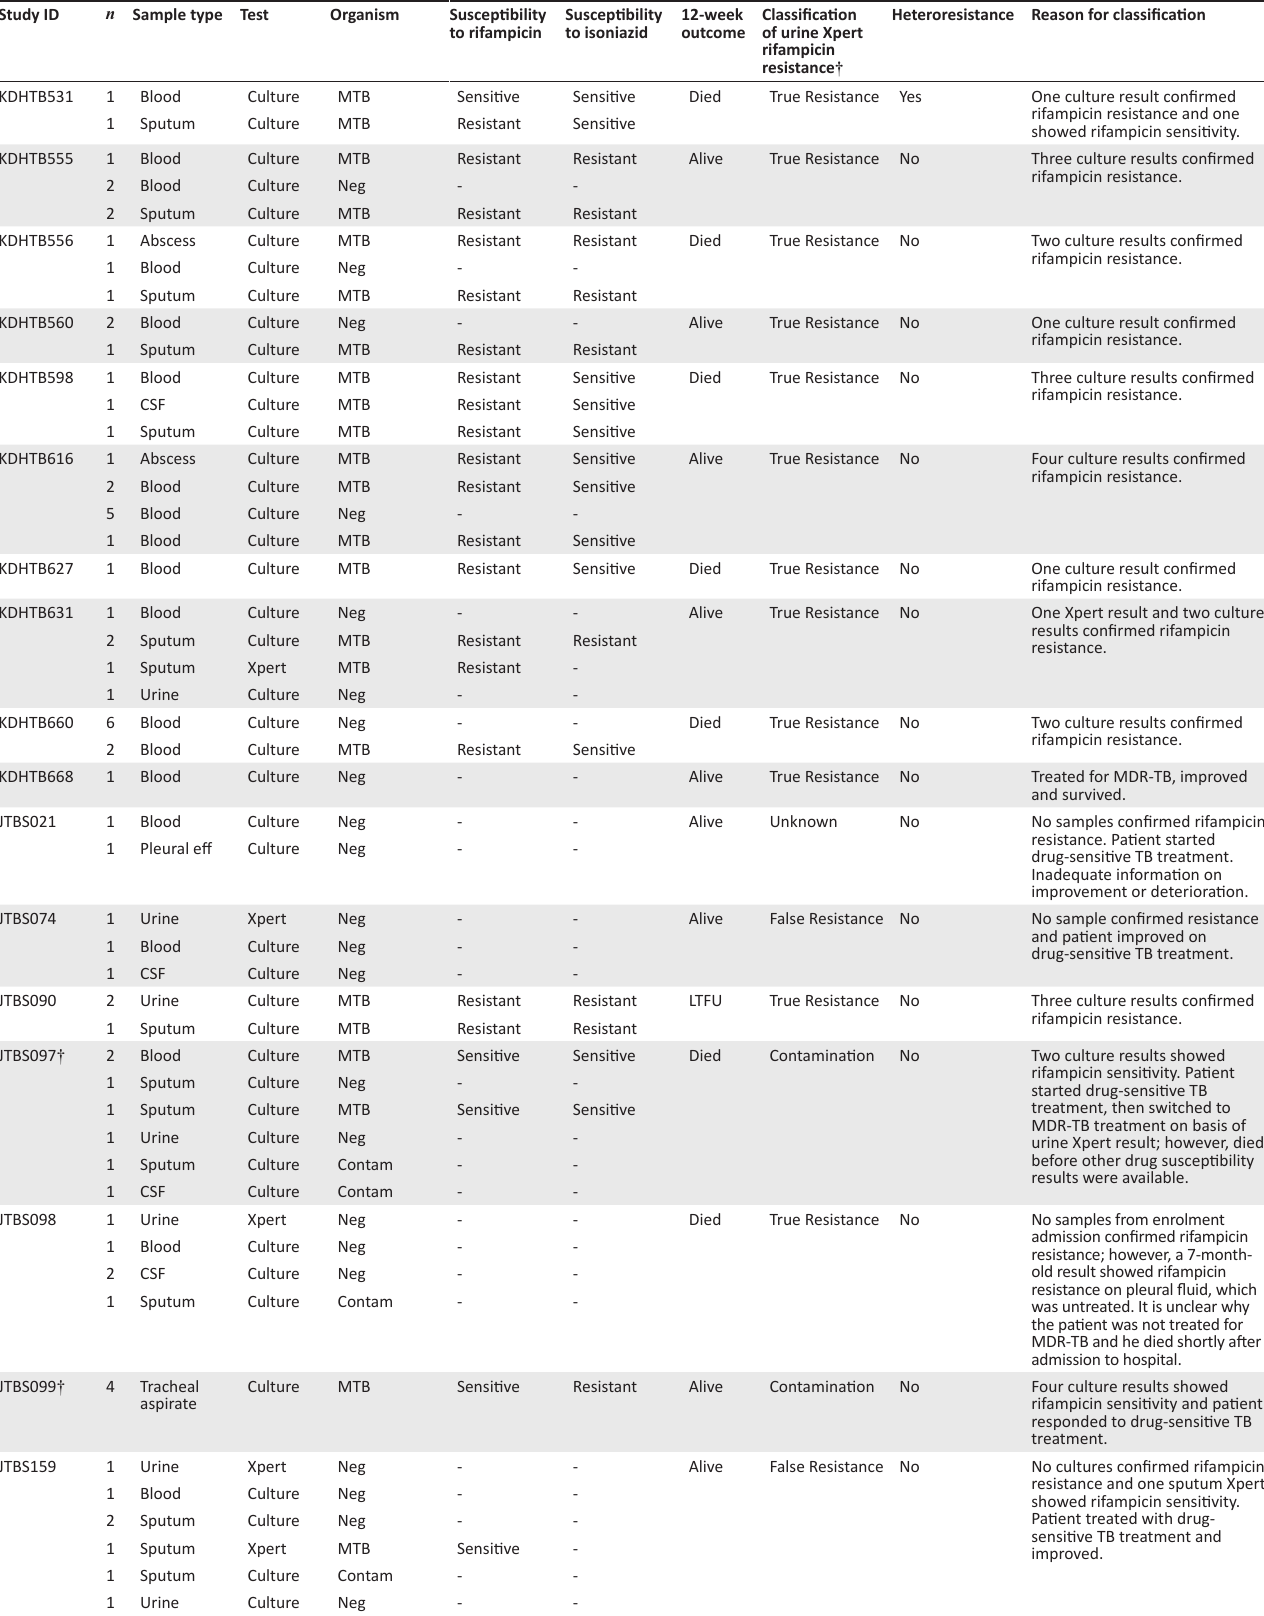
Table 1-A1 continues on the next page